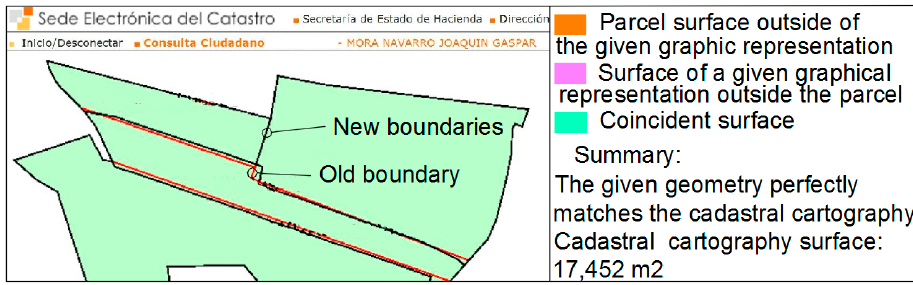
Figure 3. Positive cadastral report. Source: own elaboration.